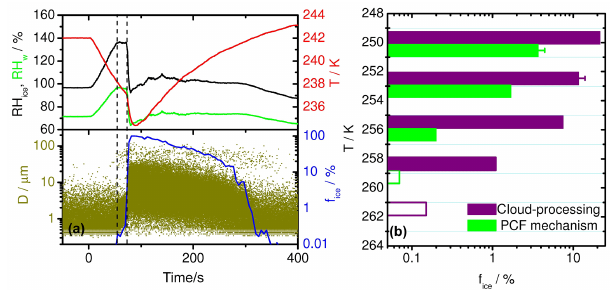
Figure 6. (a) AIDA expansion experiment with zeolite parti- cles (CBV400), simulating aerosol-processing in deep convective clouds. The data types are the same as shown in Fig. 3. (b) Temperature-dependent ice-active fractions for CBV400 particles after pre-activation by the PCF mechanism (identical to those shown in Fig. 4) and by the cloud-processing mechanism (a)